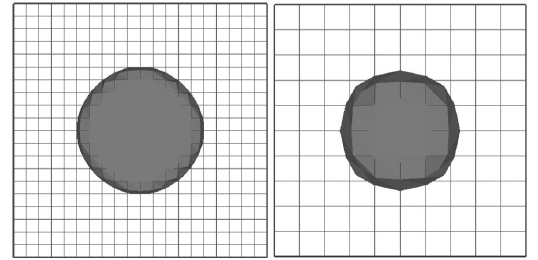
Figure 2. FAVOR technique geometry of cylinders and constructed computational rectangular grid with 0.001m × 0.001m (left) and 0.002m × 0.002m (right).